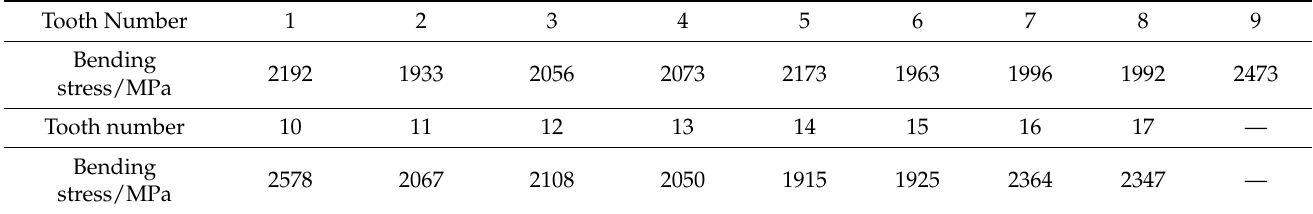
Table 2. Bending stress of the slip tooth tip.